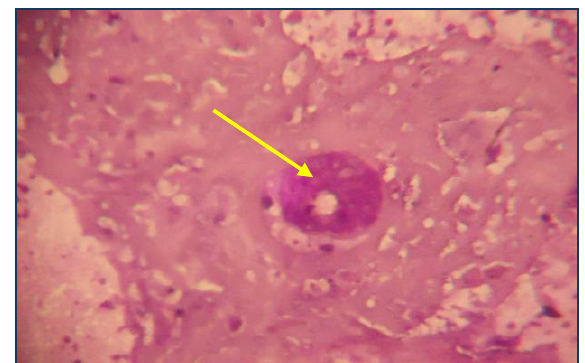
Fig, 6: Histopathological section in the liver of cat showing large necrotic area with intracellular tachyzoits (Giemsa stain 40X).